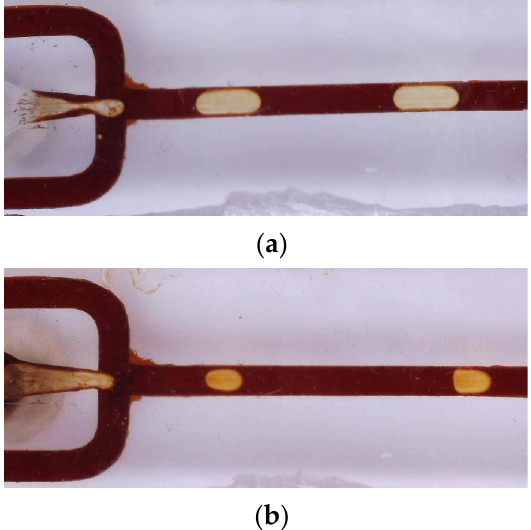
Figure 7. Behavior of non-magnetic inclusions in the MF in ESCARGOT chip with silicone walls (Figure 2c): ( a ) bubble flow; ( b ) droplet flow.